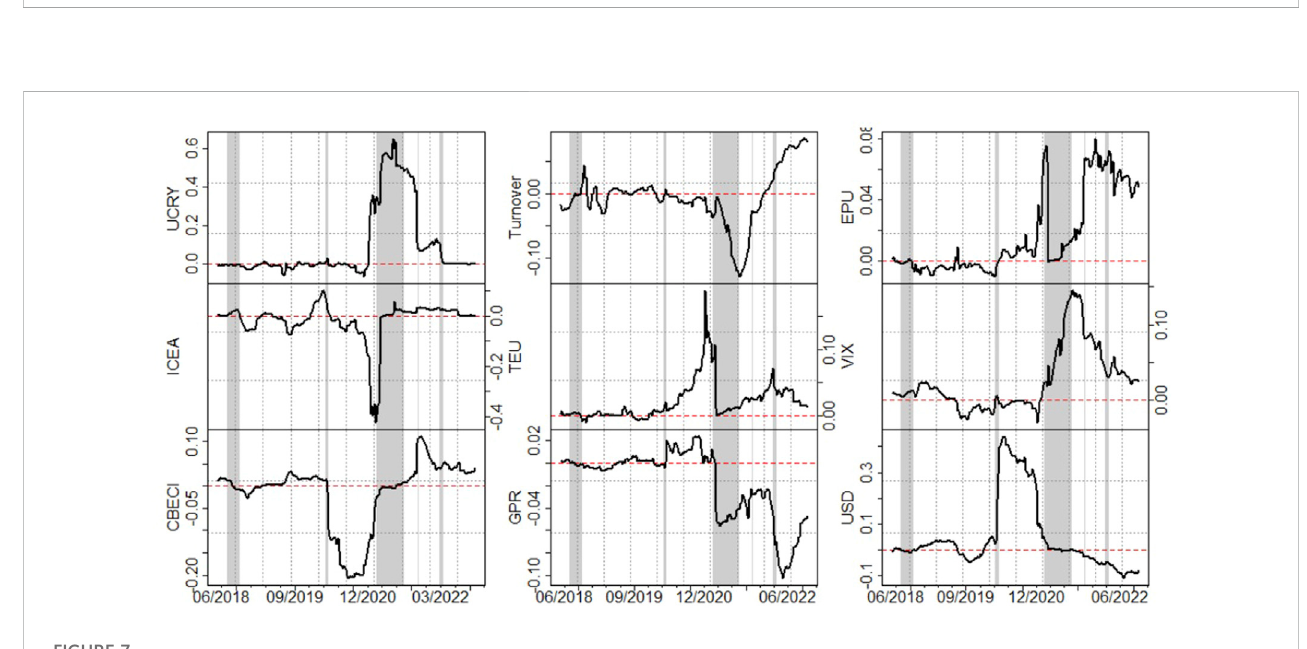
FIGURE 7 Expected coef fi cients of the potential drivers (cryptocurrencies to energy). See notes to Figure